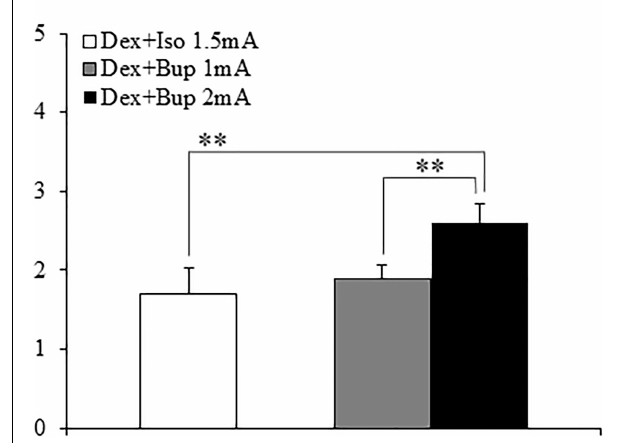
FIGURE 10 | The amplitudes of cerebral blood volume responses associated with seizure-free responses to 4 Hz forepaw stimulation under different anesthesia regimes. A bar graph showing the peak amplitude of CBV normal responses sampled from the gray matter region that showed the highest response. The white bar to the left shows the amplitude of response to stimuli of 1.5 mA administered at 4 Hz under dexmedetomidine and isoflurane anesthesia (Dex + Iso; mean ± SEM, n = 60 trials from 3 SD rats). The gray and black bars show the amplitudes of responses to stimuli of 1.0 mA and 2.0 mA, respectively, administered at 4 Hz under dexmedetomidine and buprenorphine sedation (Dex + Bup; n = 60 trials from the same 3 SD rats). ** p < 0.001; Tamhane’s